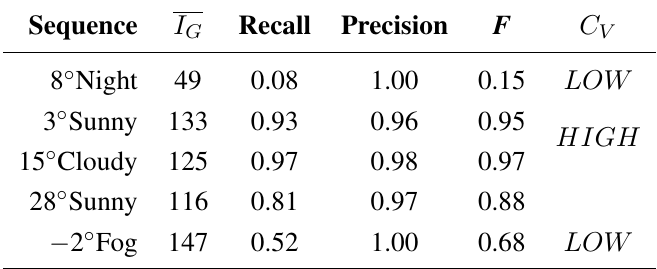
for each sequence in the visible-light V